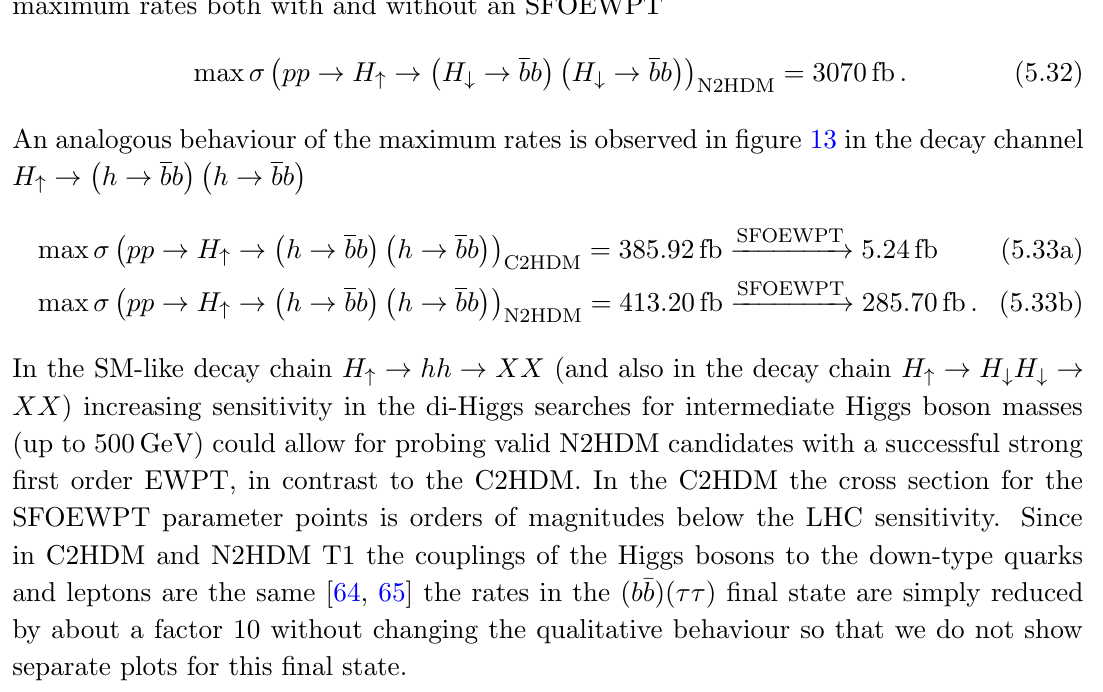
1. The di-Higgs (cid:21)